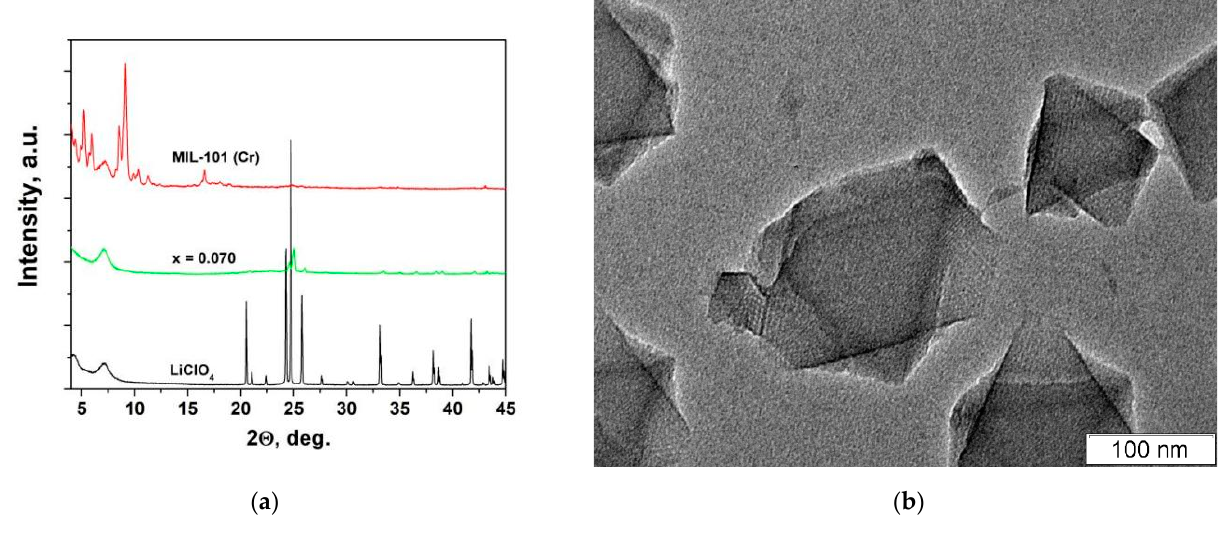
Figure 2. X-ray di ff raction data for pure components and (1 − x)LiClO 4 − xMIL-101(Cr) composite with Figure 2. X-ray diffraction data for pure components and (1 − x)LiClO 4 − xMIL-101(Cr) composite x = 0.07 after prolonged heating at 170 °C in vacuum ( a ) and electron microscopy image of initial with x = 0.07 after prolonged heating at 170 ◦ C in vacuum ( a ) and electron microscopy image of initial MIL-101(Cr) crystalline sample used for preparation of the composites ( b ). MIL-101(Cr) crystalline sample used for preparation of the composites ( b